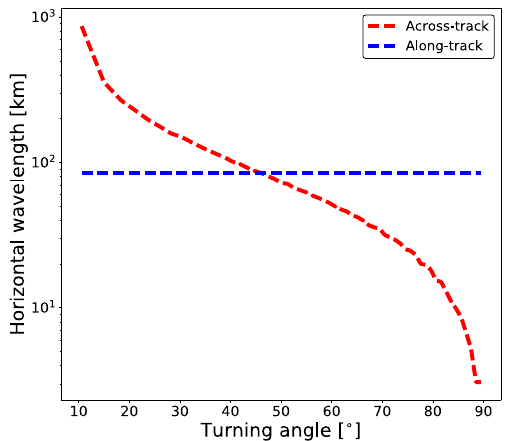
Figure 13. Comparison of the ability in resolving horizontal wave- length along the two directions under different turning angles. The blue line represents the minimal detectable horizontal wavelength in the along-track direction, and the red line represents that in the across-track direction. This sensitivity curve is obtained based on the simulation of idealized atmosphere and observation.